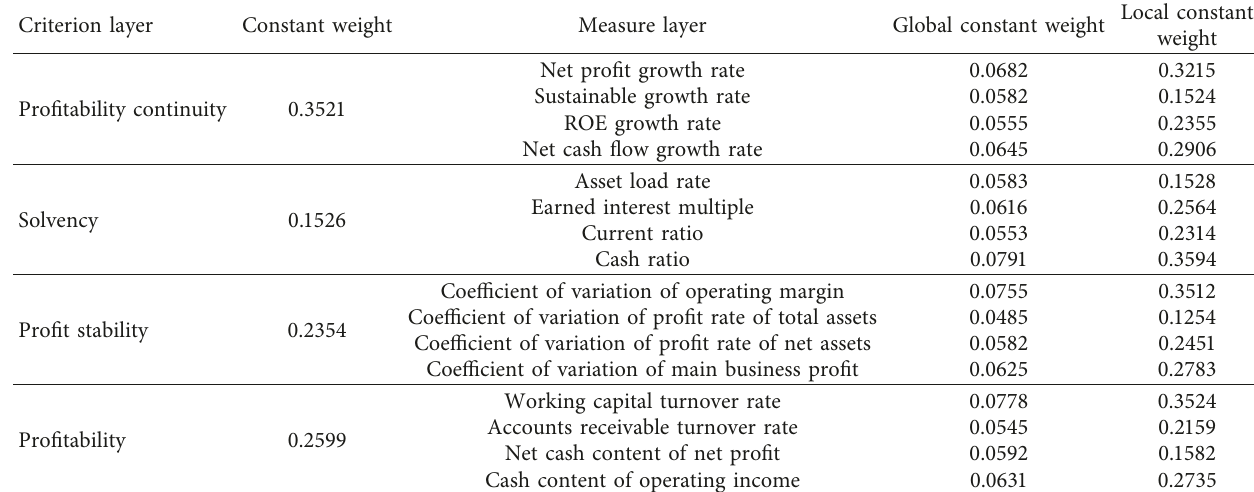
Table 3: Weight calculation results.